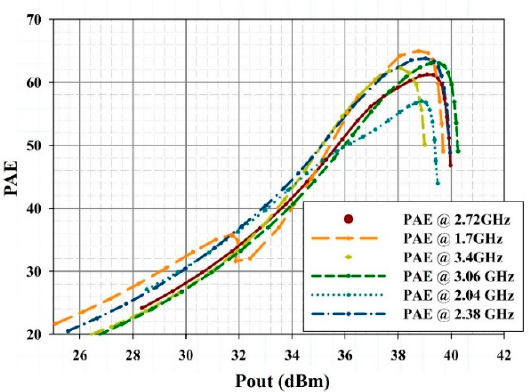
Figure 17. Measured PAE versus P out for the final Doherty Power Amplifier.